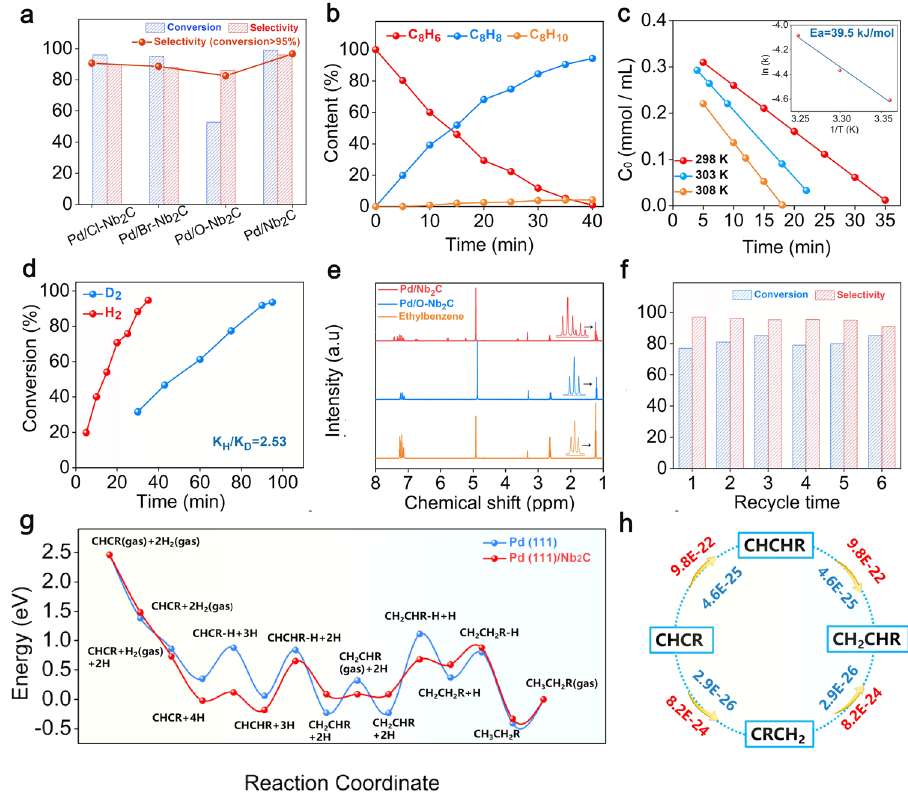
Fig. 5 | Catalytic performance of Pd/Nb 2 C MXenes. a Catalytic performance of phenylacetylene on the different Pd/Nb 2 C MXenes. Reaction conditions: 5mL ethanol, 2mmol phenylacetylene, 10mg catalysts (0.023mol % Pd), T=298K, H 2 pressure=0.1MPa. b Phenylacetylene hydrogenation reaction plots of Pd/Nb 2 C. c Kinetic curves of Pd/Nb 2 C at different temperatures and the activation energy. d Primary isotope effect observed for Pd/Nb 2 C in phenylacetylene hydrogenation. e NMR data for the products of styrene hydrogenation carried out by different Pd